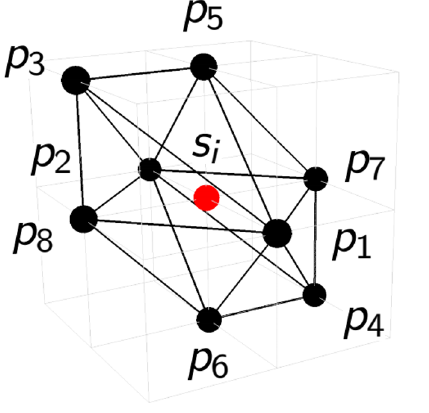
Figure 43 . Toric diagram for Model